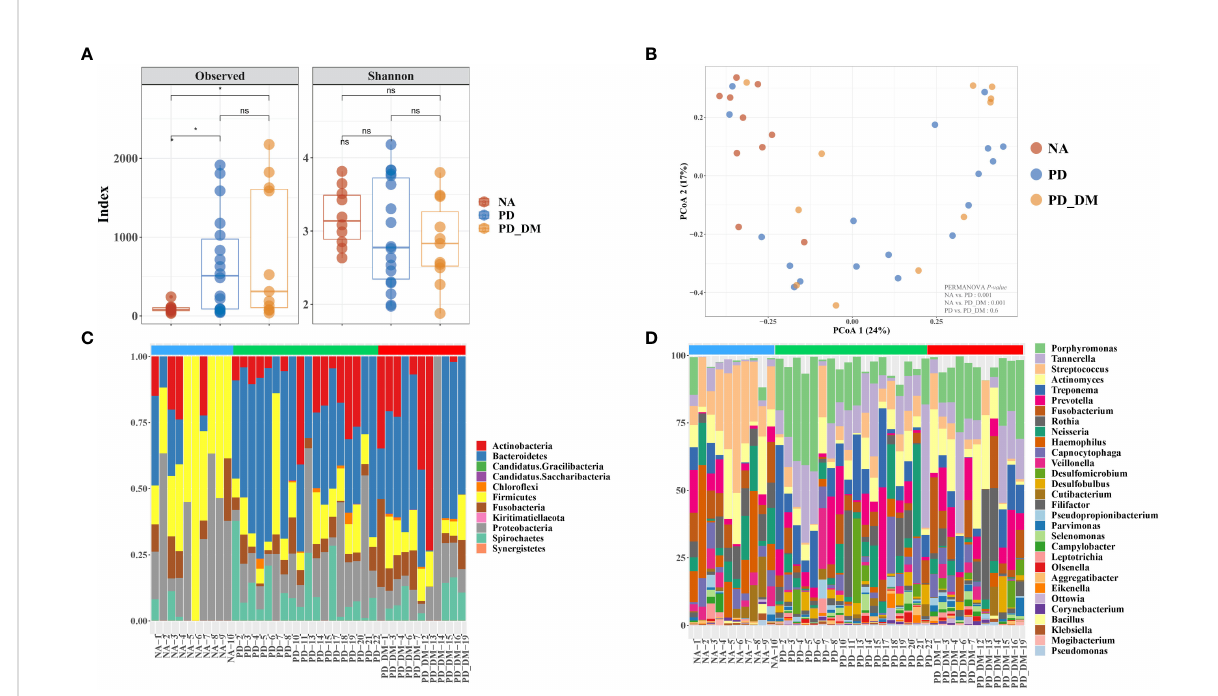
FIGURE 1 Compositional distinction of oral microbiota between NA, PD, and PD_DM. (A) The comparison of oral microbiota alpha diversity between each group, including species richness (represented by Chao1) and evenness (represented by Shannon and pielou). (B) The principal component analysis (PCA) plot is shown generated by applying phyloseq to the species level count data. Each point represents one sample, and the samples are colored by status. The percentage of variation explained by each principal component is depicted on each axis. Stacked bar-plot representation of microbiota compositions during NA, PD, and PD_DM, with taxonomic features collapsed at the level of (C) phyla and (D) genera. The genera represent the top 30 strains. Blue bar, NA; green bar, PD; red bar, PD_DM. *p < 0.05; ns, no signi fi